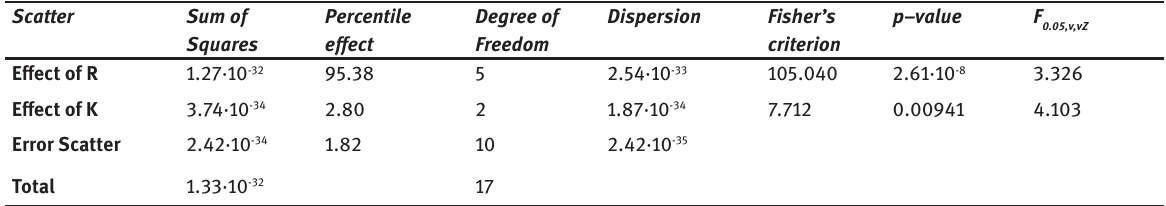
Table 6: The effect of the factors; the results of the dispersion analysis.